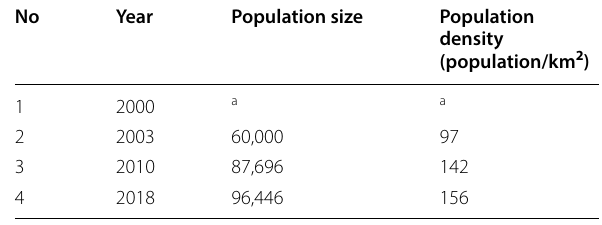
Table 10 Population change in Chewaka